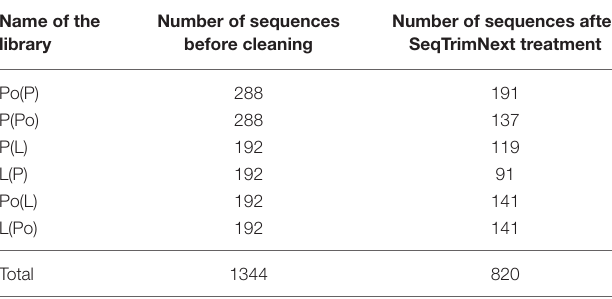
TABLE 4 | Summary stats about the pre-processing of the libraries. Name of the library